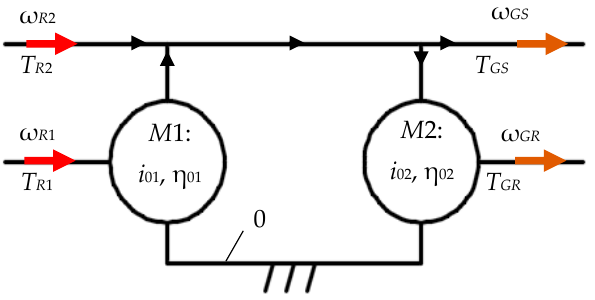
Figure 3. Block diagram of 1-DOF speed increasers with two counter-rotating inputs and two counter-rotating outputs, obtained by connecting in parallel the planetary gear sets M 1 and M 2.